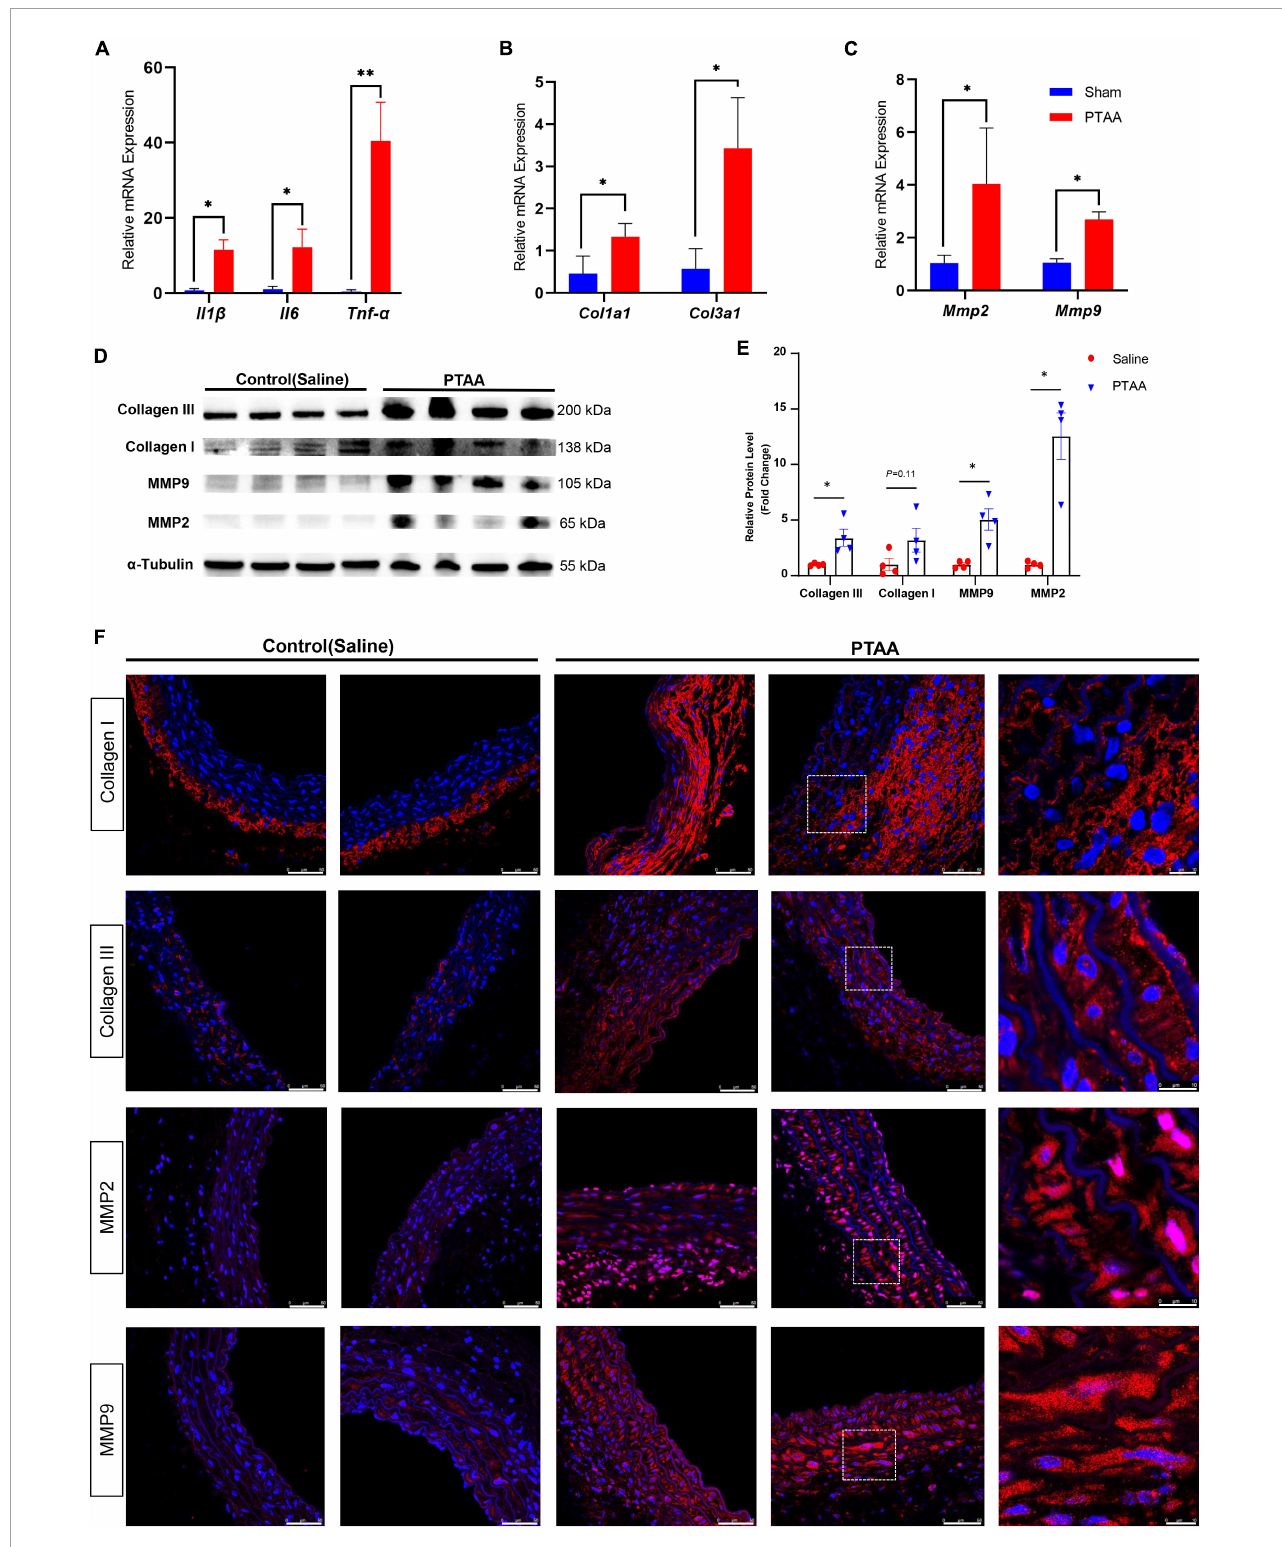
FIGURE5 Quantification analysis and immunofluorescence staining of the matrix metalloproteinase and collagen molecules. (A) RT-qPCR analysis of the proinflammatory markers, IL-1 β , IL-6, TNF- α . (B) RT-qPCR analysis of the Col1a1, Col3a1 . (C) RT-qPCR analysis of the Mmp2 and Mmp9 ; n = 4 in both groups, the difference was compared by two-tailed Mann–Whitney tests, ∗ P < 0.05, ∗∗ P < 0.01. (D) Immunoblot analysis of the COL1A1, COL3A1, MMP2, and MMP9 in protein lysates from sham-operated thoracic aorta and the PTAAs (28 days after surgery). (E) Quantification analysis of the protein density in the forementioned Immunoblot analysis. Mean ± s.e.m.; by two-tailed Mann–Whitney tests; ∗ P < 0.05. (F) Representative immunofluorescence images of proximal thoracic aortic aneurysm (PTAA) lesions or controlled thoracic aorta stained for COL1A1, COL3A1, MMP2 or MMP9 (Red), and DAPI